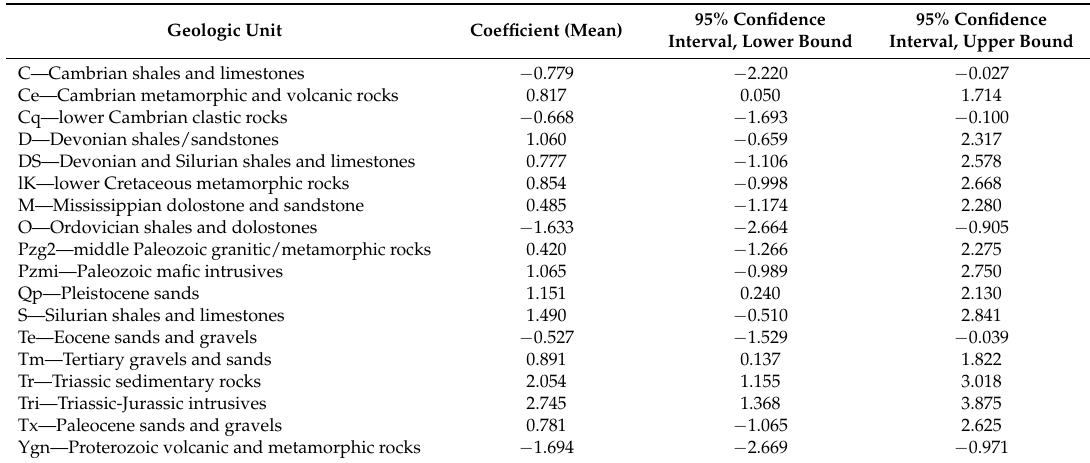
Table 5. Results of variable selection.